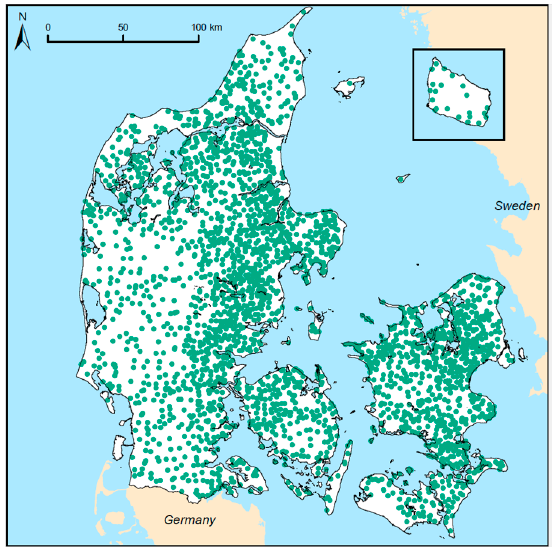
Figure 2. Locations of the 2948 public waterworks included in this study.